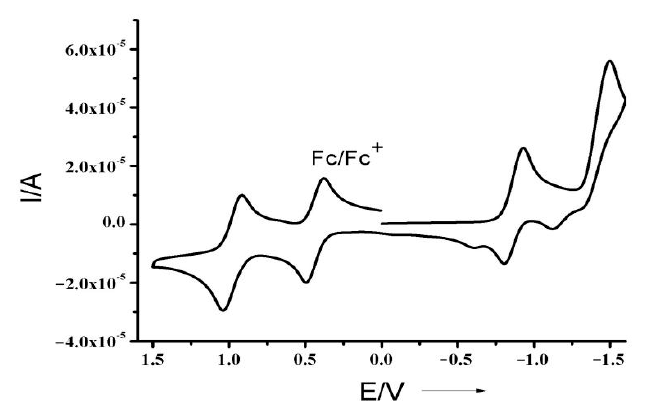
Figure 4. Cyclic voltammetry of BTN. The scanning speed is 0.1 V/s, and the scanning direction is from 0 to positive, then back to negative.